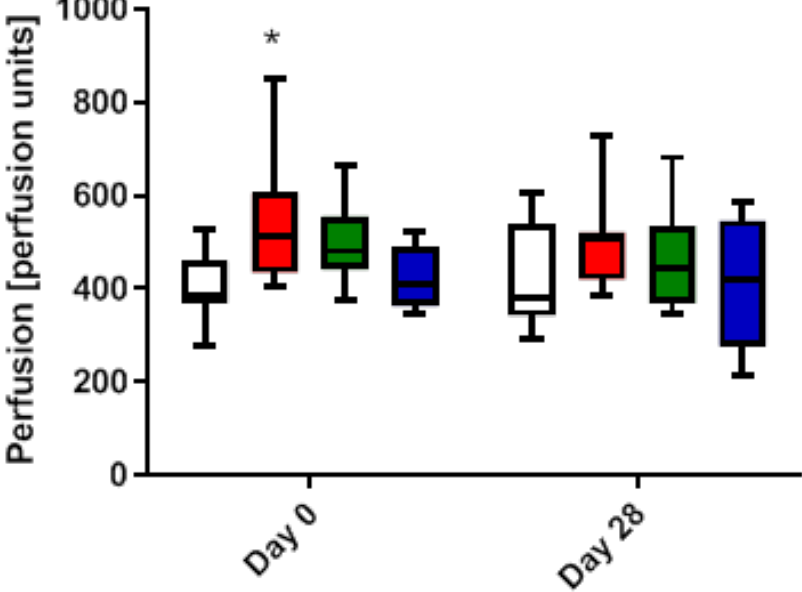
Figure 5. Effects of pulsing LED light therapy by Repuls of different wavelengths on perfusion in the wound given in arbitrary units [AU] immediately after treatment. Wounds were created on day 0 and treated every other day for 6 min for 28 days. Perfusion was analyzed directly after treatment on day 0 and day 28 by laser Doppler imaging (LDI). The color of the bars shows the color of PBM wavelength; from right to left control, red, green and blue light, respectively. n = 8, * p < 0.05, compared to the not illuminated control.